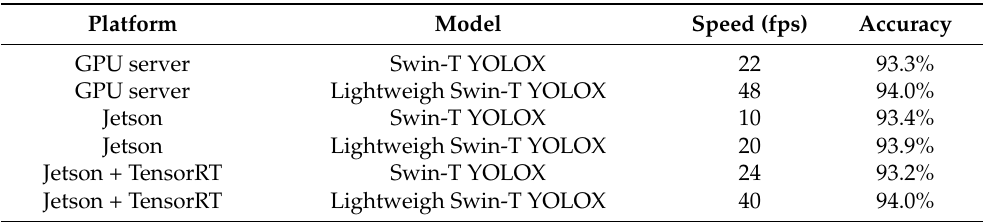
Table 4. Overall performance comparison of the Swin-T YOLOX model deployed using different deployment